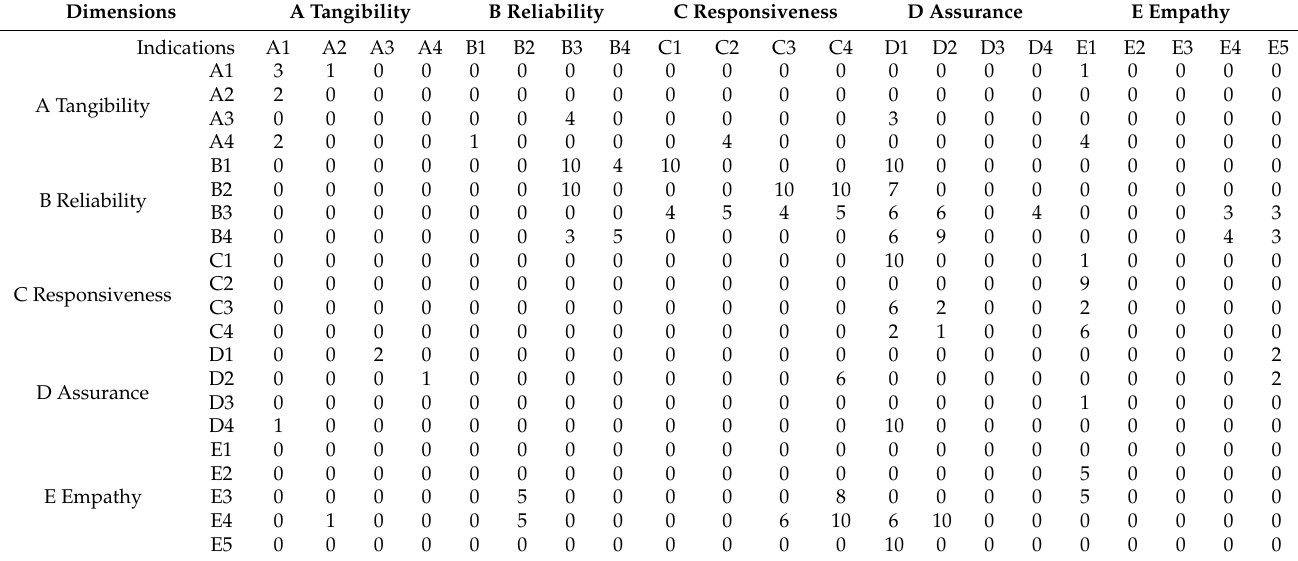
Table 4. Indicator dependency relationship